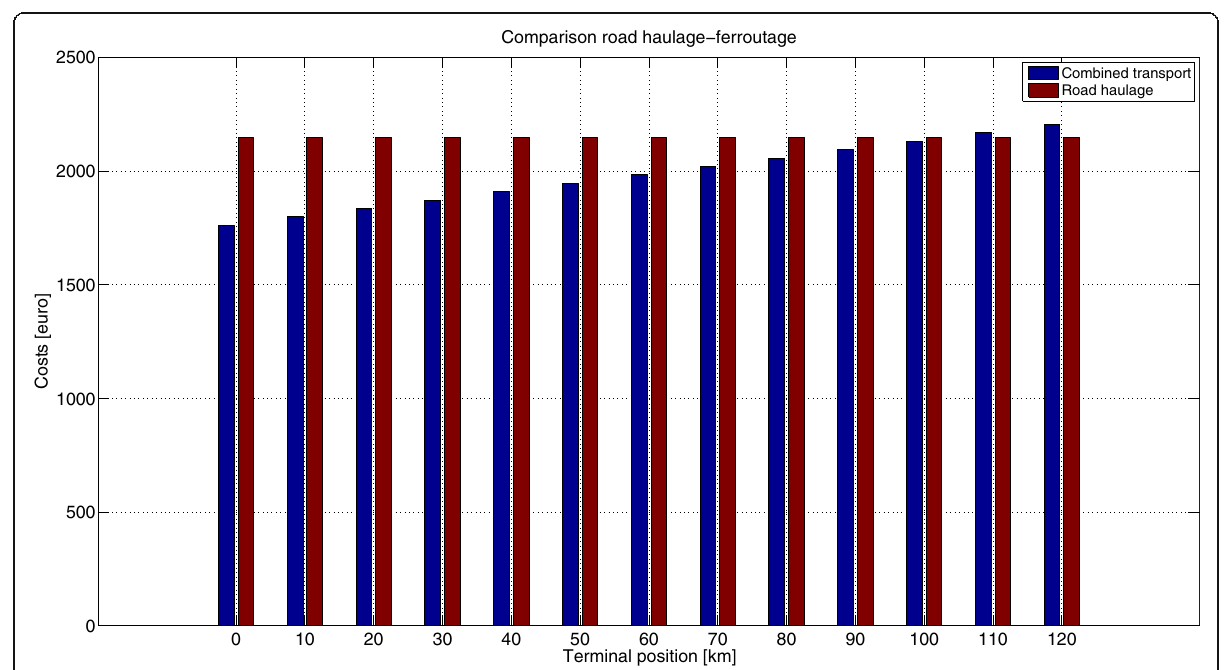
Fig. 10 Comparison of all the transport costs (related to the transport of one standard ITU 40 ′ )